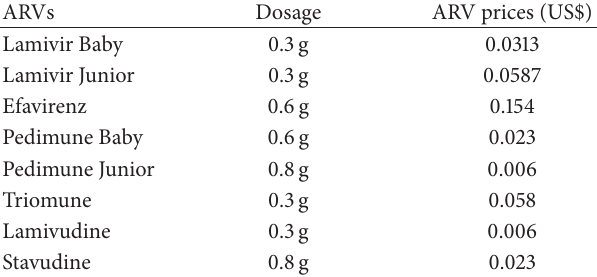
Table 6: Unit prices of ARVs